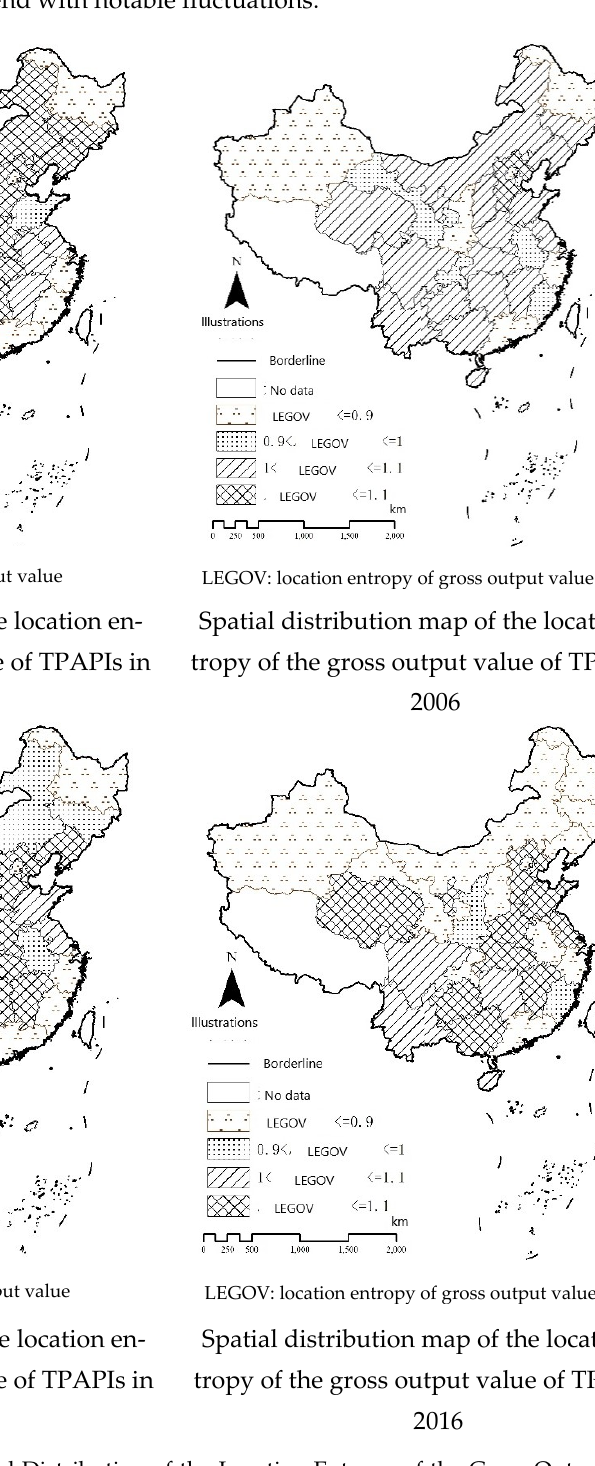
Figure 1. Spatial Distribution of the Location Entropy of the Gross Output of TPAPIs from 2000 to 2016.